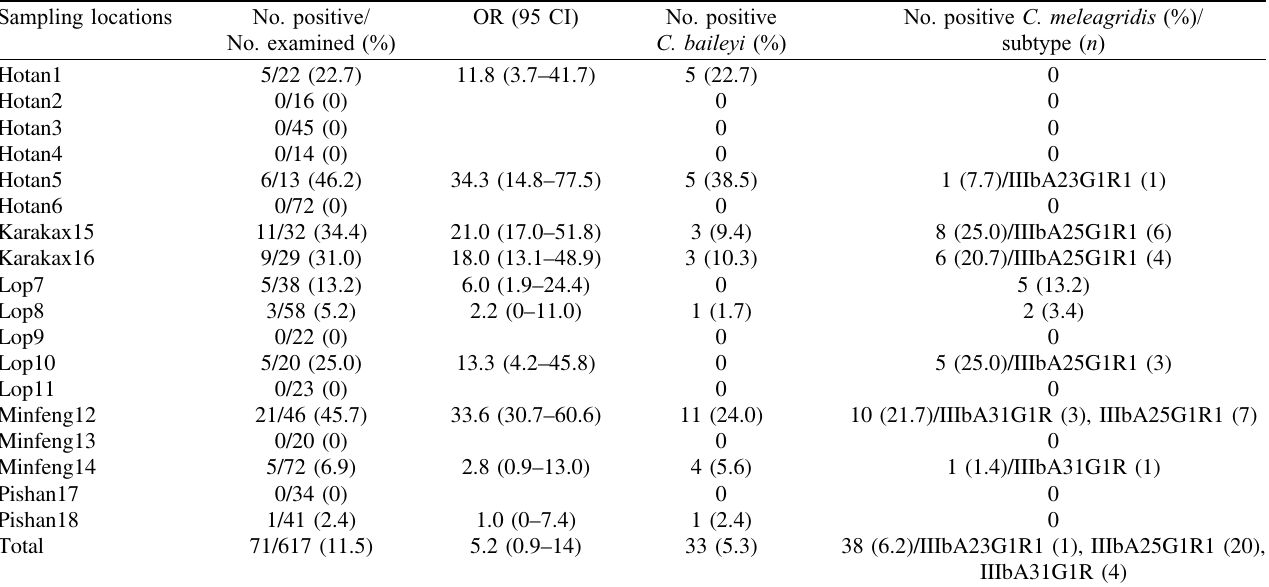
Table 1. Prevalence and distribution of C. baileyi and C. meleagridis as well as subtypes of C. meleagridis in chickens in this study. Sampling